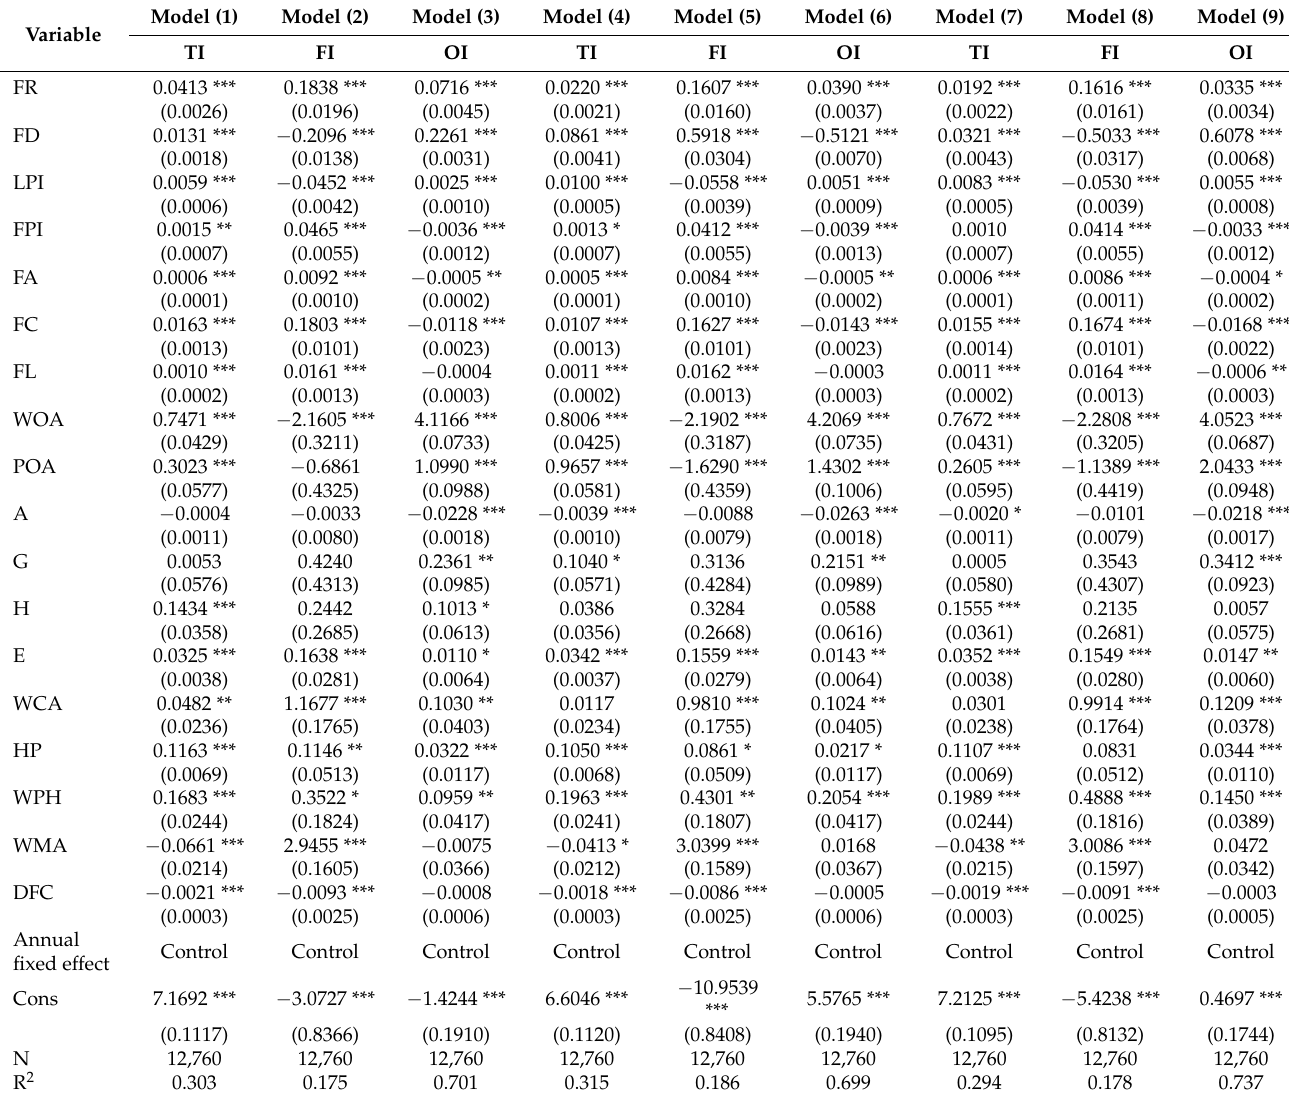
Table 3. Regression results of robustness